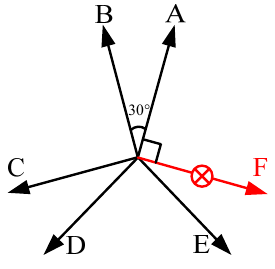
Figure 10. Schematic diagram of one-phase-open